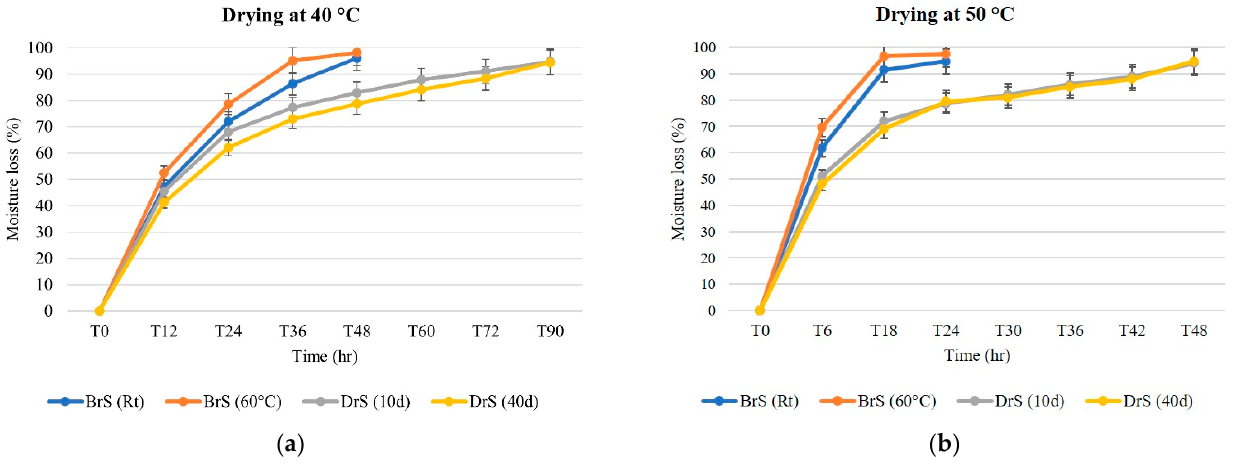
Figure 1. ( a ) Moisture loss % over time under 40 °C drying temperature for DrS (Rt), DrS (60 °C), BrS (10d), and BrS (40d) caper samples. ( b ) Moisture loss % over time under 50 °C drying temperatures for DrS (Rt), DrS (60 °C), BrS (10d), and BrS (40d) caper samples.